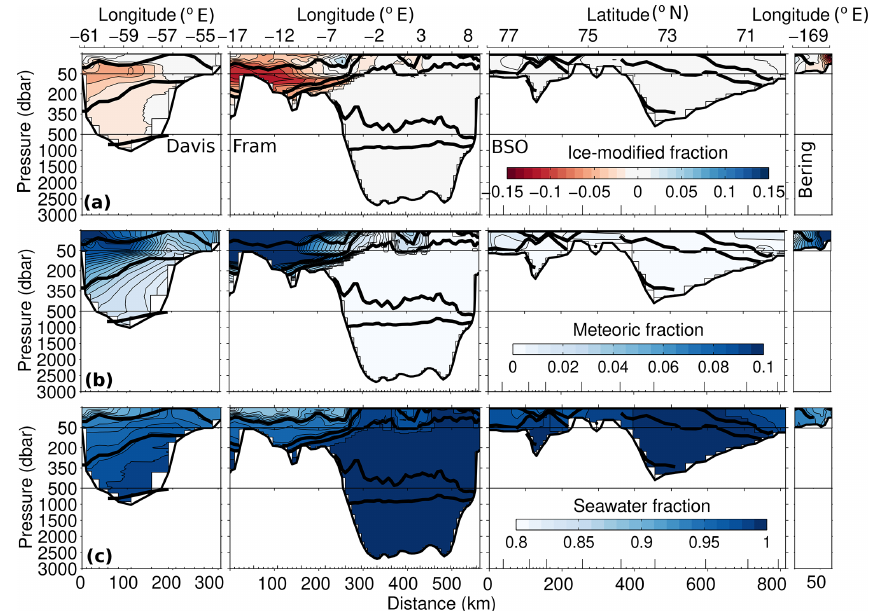
Figure 5. Sections of ice-modified fraction (a) , meteoric fraction (b) and seawater fraction (c) , for the 3EM model, clockwise around the four gateways from Davis Strait to Bering Strait. Solid black lines indicate the isopycnal surfaces separating the main Arctic water masses as described in Tsubouchi et al. (2012). End members used were the mean of the literature values (see Tables 2 and 3). Note different colour scales for each panel.